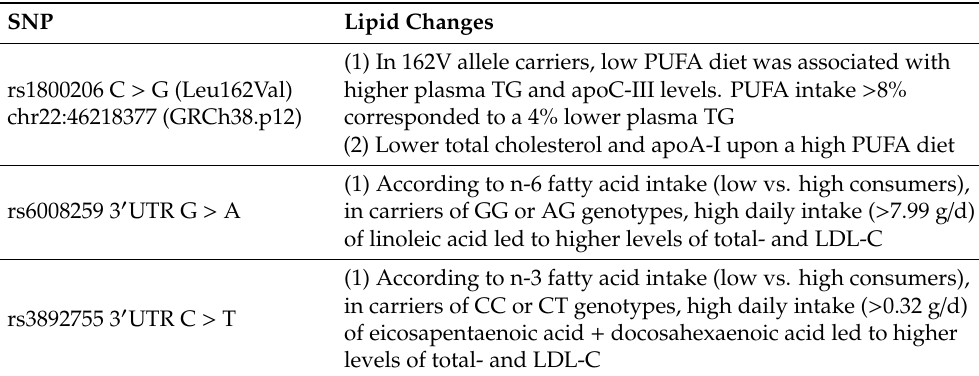
Table 2. Interaction between PPAR α polymorphisms and diet on plasma